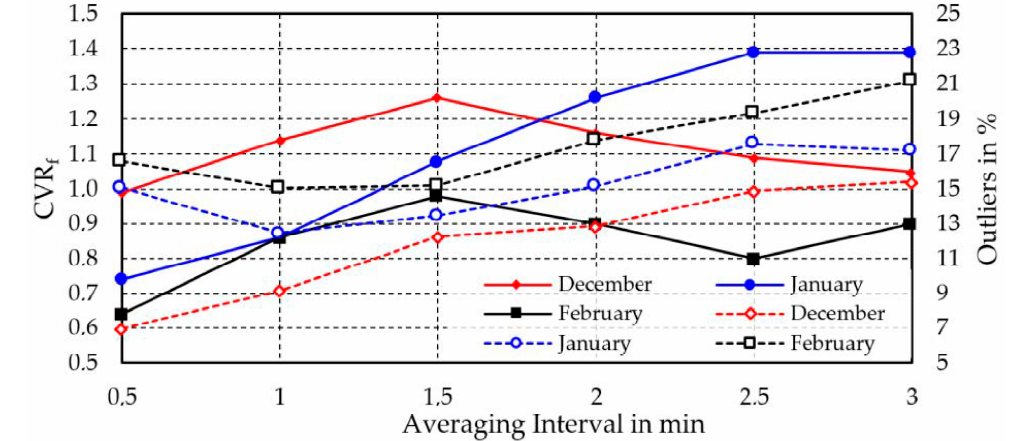
Figure 10. Averaging interval e ff ect on CVR factors.